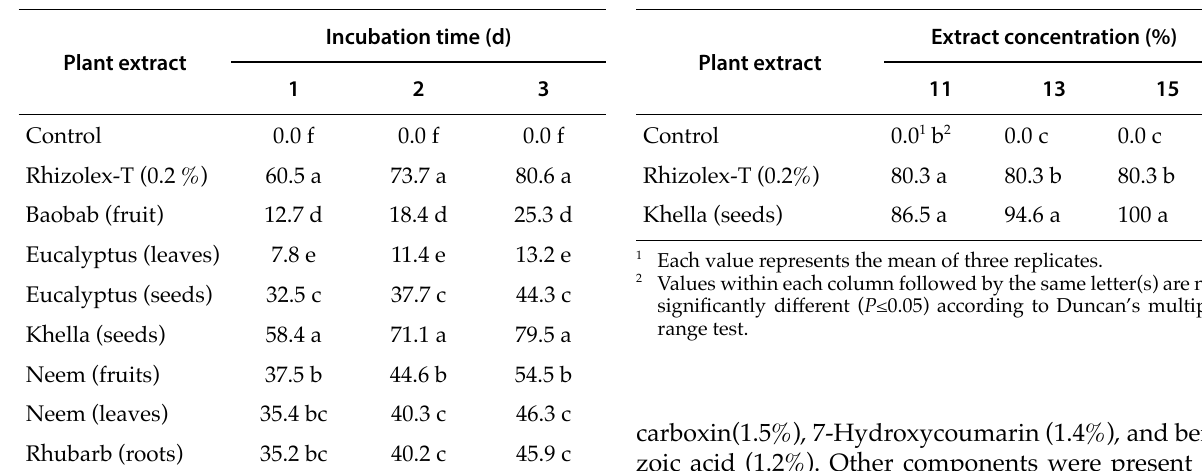
Table 4. Mean growth reduction (%) of Rhizoctonia solani mycelium when exposed to different concentrations of Khella methanol extracts.